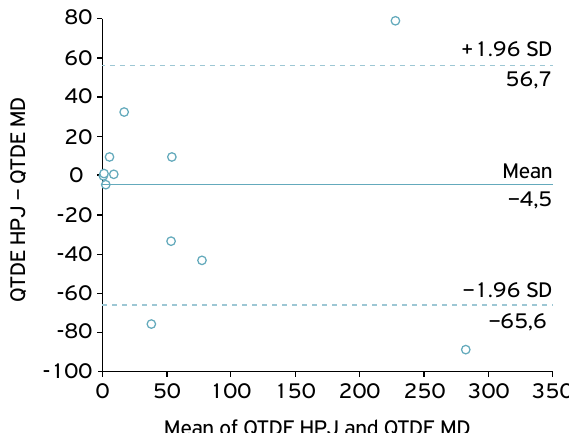
Figure 1. Joint comparison of all positive evaluations between direct (MD) and HPJ methods.